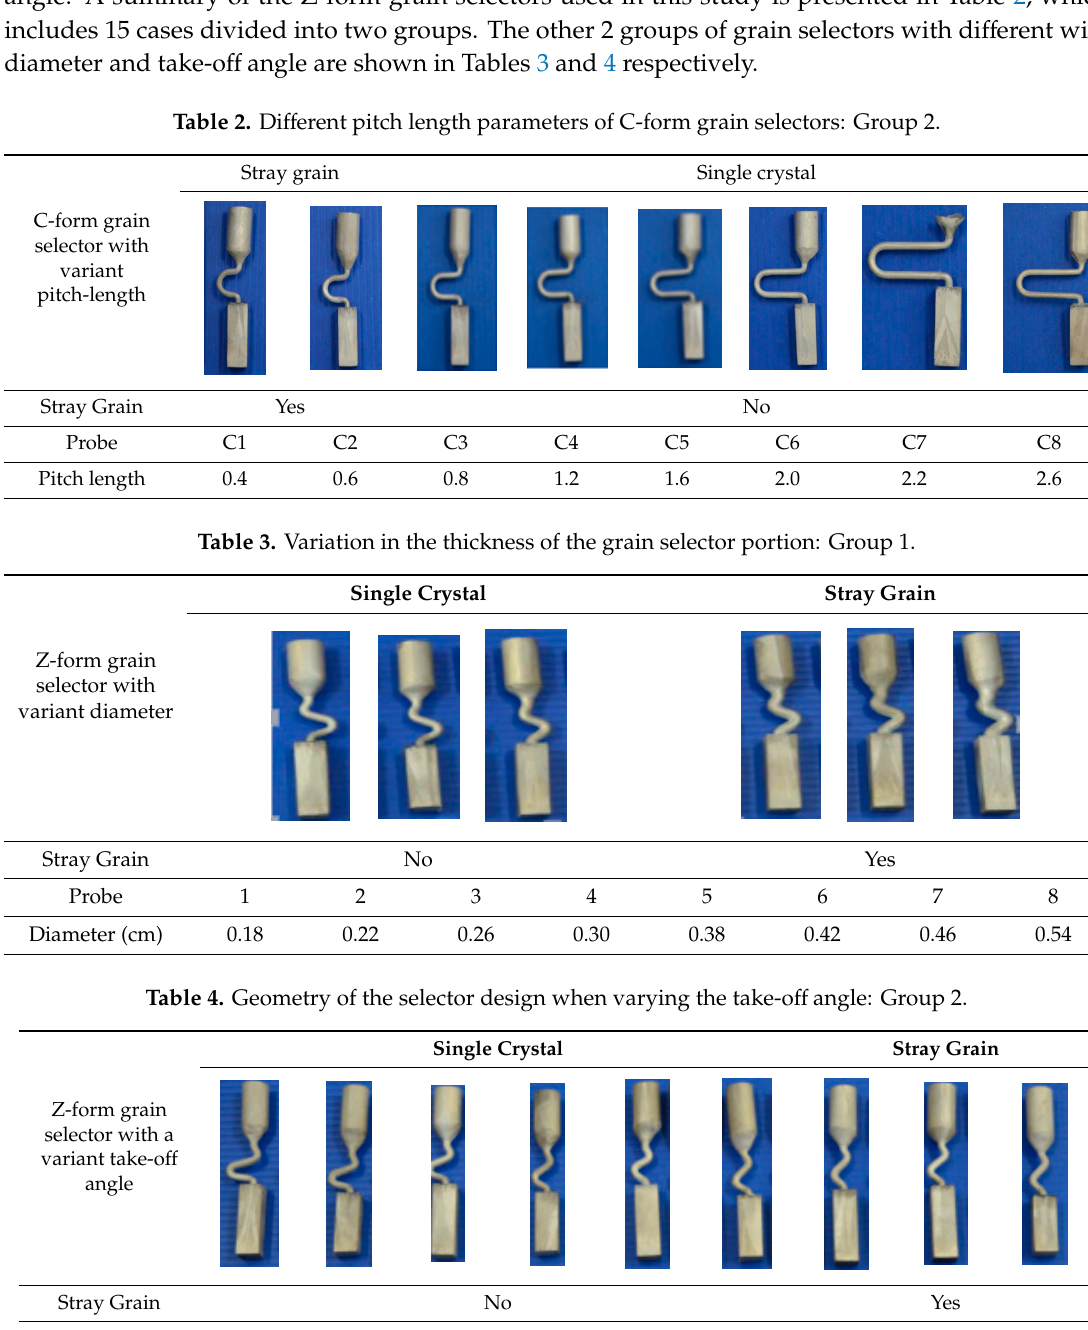
Table 4. Geometry of the selector design when varying the take-off angle: Group 2.